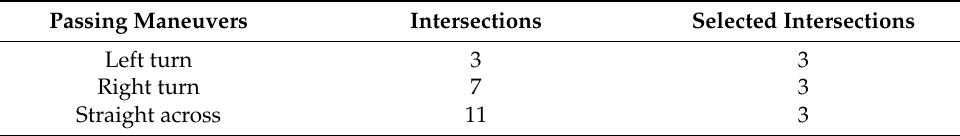
Figure 2. The distribution of traffic accidents in Changsha city from 2014 to 2016 and the selected test route. On the left, orange expresses the largest number of occurred accidents, and the experi- mental route is selected in the rectangle. On the right, the composition of red arrows indicates the experimental route, and the number denotes urban intersections passed through.